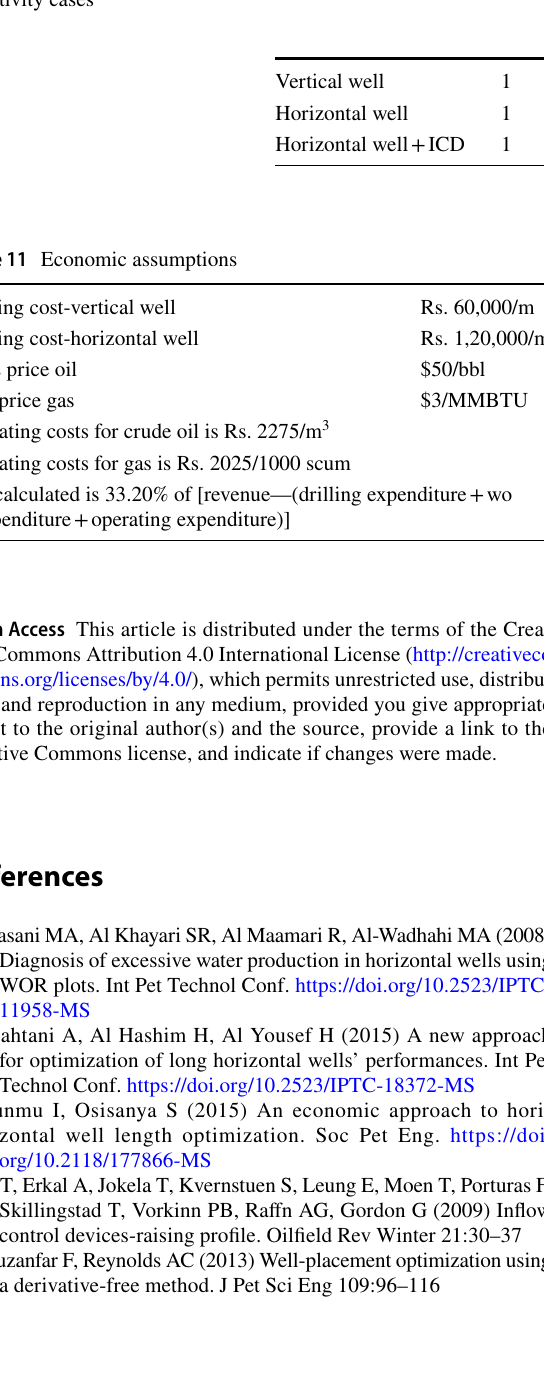
sensitivity cases